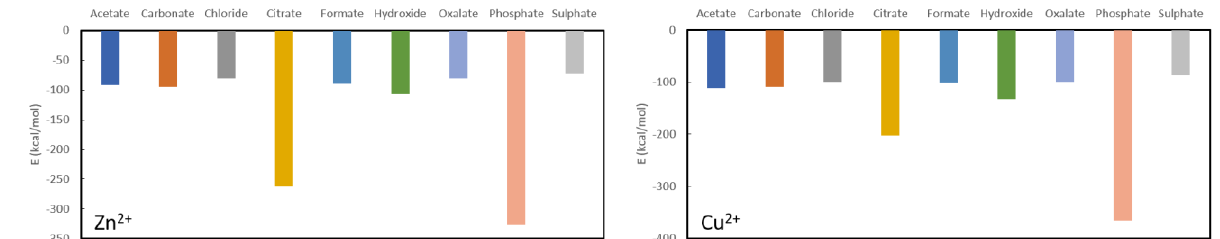
Figure 5. Formation energies for the complexes with Zn 2+ ( left ) and Cu 2+ ( right ). Results for the final investigated cations are collected in Figure 6. It is immediately clear that Fe 2+ may be expected to serve well as a phosphate binder with a complexation energy to phosphate of −460.3 kcal/mol in comparison to relatively low formation energies of the other studied complexes with the exception of citrate (−419.9 kcal/mol). Indeed, the remaining ligands have complexation energies of −150.1 kcal/mol for acetate, −145.1 kcal/mol for carbonate, −127.3 kcal/mol for chloride, −143.0 kcal/mol for formate, −145.4 kcal/mol for hydroxide, −137.3 kcal/mol for oxalate and −119.5 kcal/mol for sulphate. Given these numbers, Fe 2+ cannot be expected to serve as a good oxalate binder as the